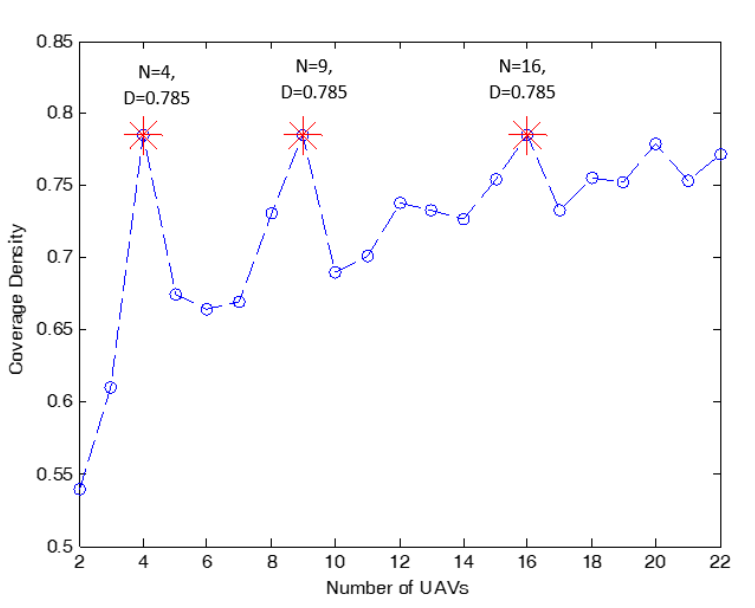
Figure 7. The coverage density for n = 2 to n = 22 identical circles inside a square coverage area with the dimensions of 2 km × 2